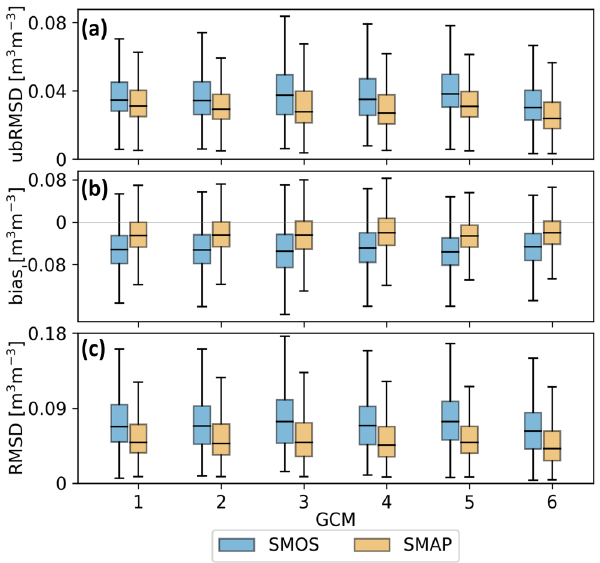
Figure 2. Spatial box plots of (a) ubRMSD, (b) bias, and (c) RMSD, for five GCMs (1 to 5 – GFDL-ESM4, IPSL-CM6A-LR, MPI- ESM1-2-HR, MRI-ESM2-0, and UKESM1-0-LL) and the median across GCMs (6). SIM2 SSM is compared with SMOS (blue; left) and SMAP (beige; right) SSM for April 2015 through December 2020. Only SSM values for the months March through October are considered in the computation of the skill metrics, and the spatial coverage is different for SMOS and SMAP. The boxes represent the values in the interquartile range (IQR), the line in the box corre- sponds to the median, and the whiskers extend to Q1–1.5IQR and Q3 + 1.5IQR or are cut off if all data points fall into the interval (outliers are not